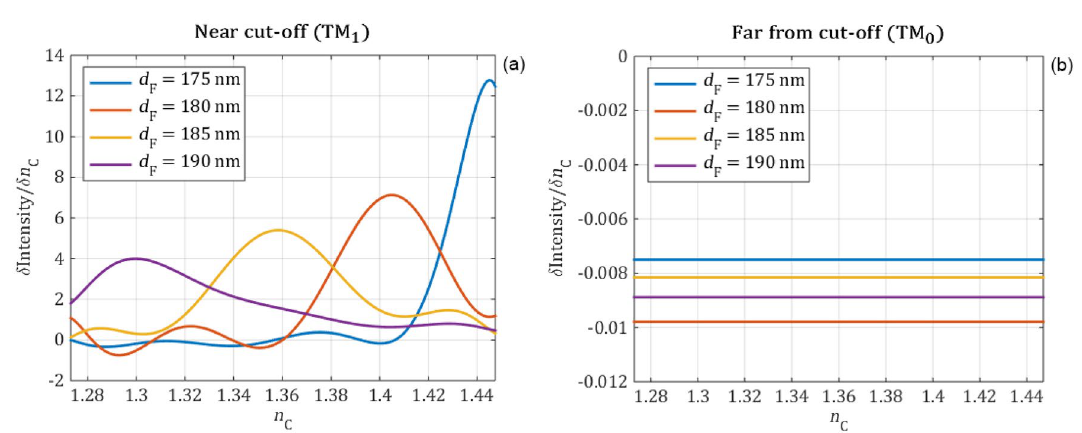
Figure 10. The sensitivity of the intensity difference for the near cut-off (a) and far from cut-off (b) modes as a function of the refractive index of the cover layer for different waveguide film